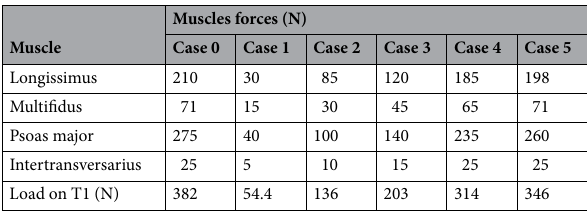
Table 3. Muscle force inputs.